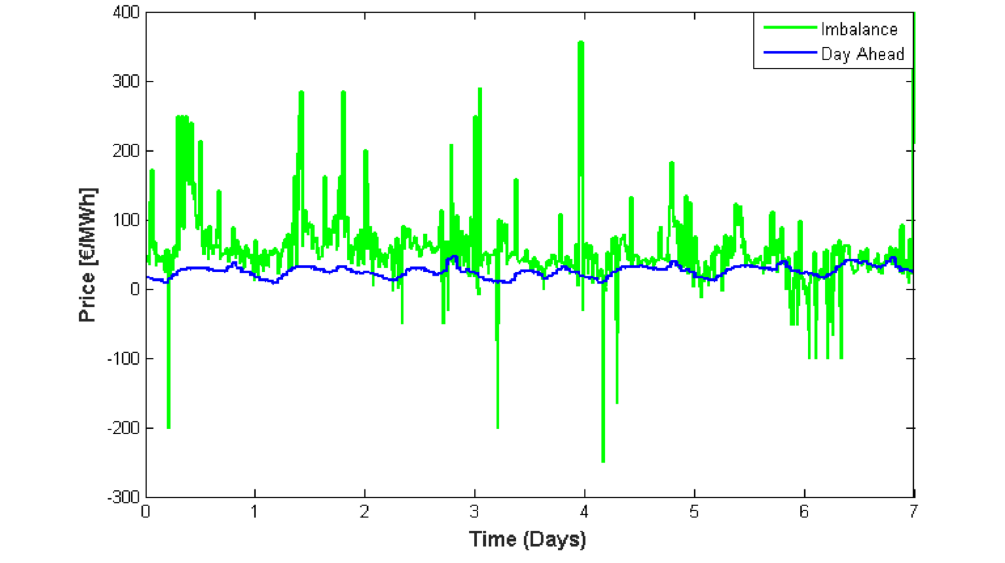
Figure 6. Imbalance and day ahead price for one